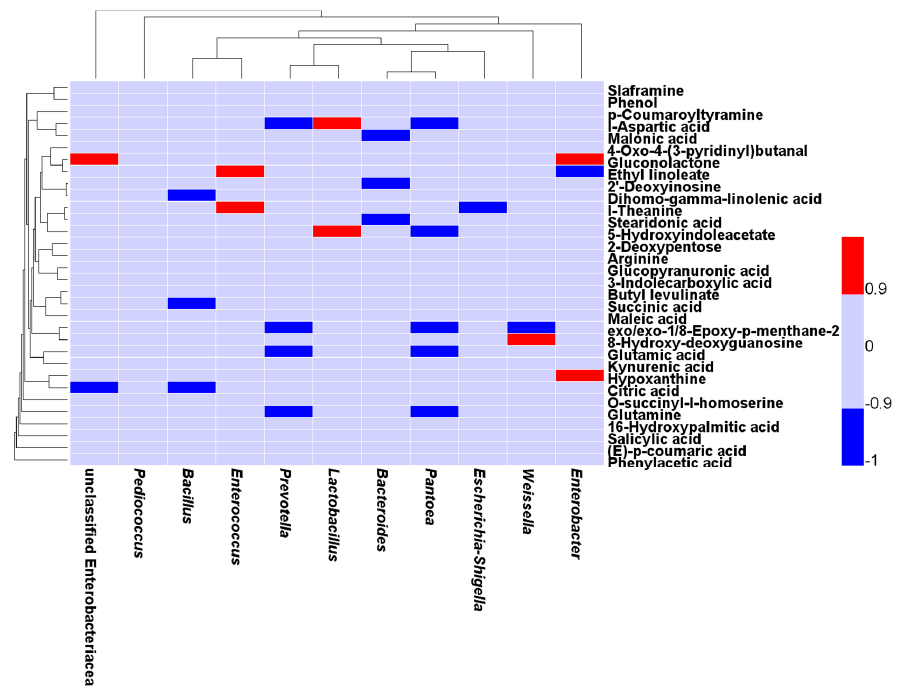
Figure 6. Correlations between microbes and metabolites in fermented feed samples. Only the genera (relative abundance ≥ 0.5%, P < 0.05) for which abundance was significantly related to compounds (VIP > 1.2) are presented. The Spearman correlation coefficient was used to assign a color to the cells. Red indicates a significantly positive correlation (r > 0.900, P < 0.05) and blue indicates a significantly negative correlation (r < − 0.900, P < 0.05).